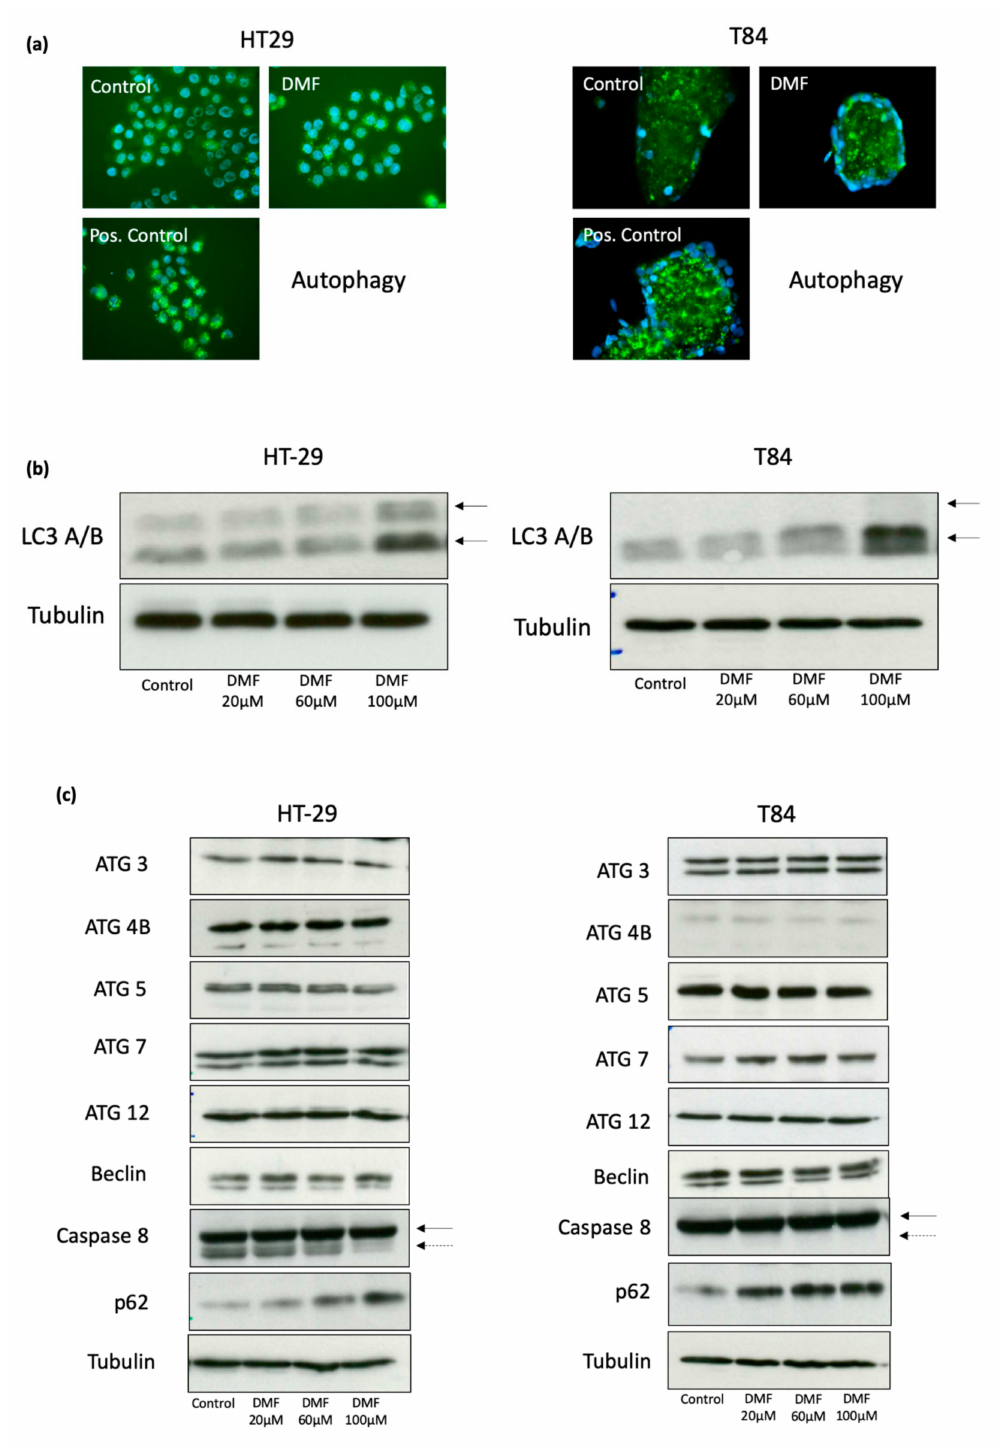
Figure 6. DMF induces autophagy in HT-29 and T84 colon carcinoma cell lines. ( a ) representative immunofluorosecence of autophagy using Cyto-ID ® assay. Cells were treated with DMF (100 µ M) or solvent for 24 h. As a positive control Rapamycin (500 nM) + Chloroquine (10 µ M) were used; ( b ) representative Western blot analyzes of LC3 A / B. Cells were treated for 24 h with vehicle or DMF for the indicated concentrations. The two arrows mark the type I (upper arrow) and type II (lower arrow) LC3A / B; ( c ) representative Western blot analysis from di ff erent autophagy associated proteins. Cells were treated for 24 h with vehicle or DMF for the indicated concentrations. Comparable results were obtained from at least three independent